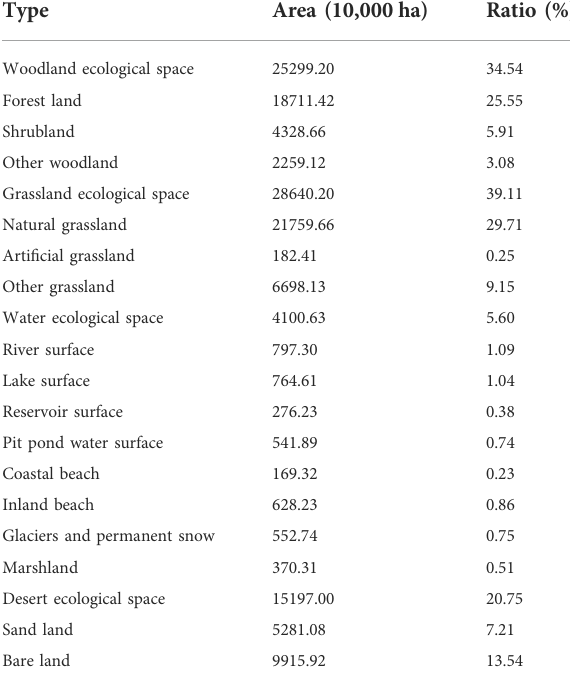
TABLE 3 Area of ecological space types in